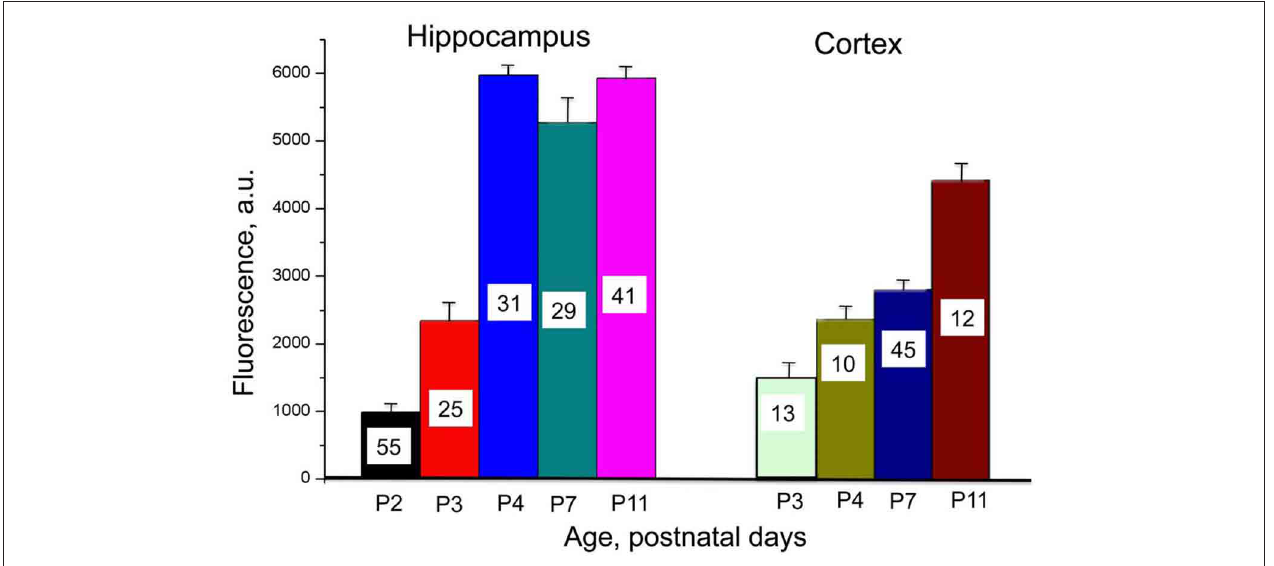
(shown below columns). An excitation wavelength of 440nm for a duration of 20ms was used with a × 60 objective. Bars are mean ± SEM values. Number of analyzed cells for each age is shown in